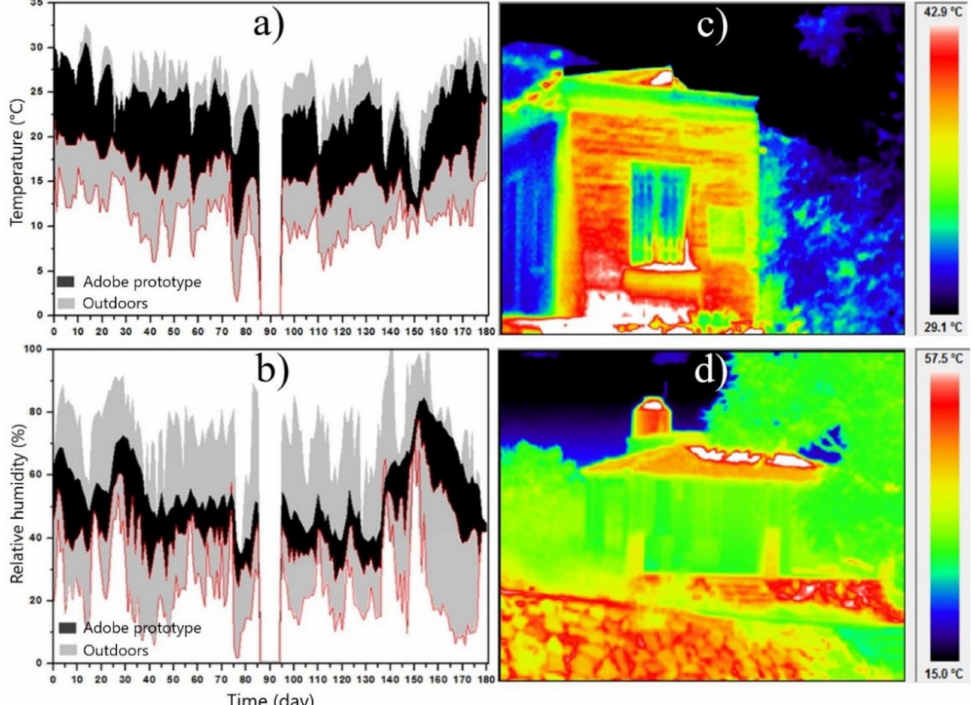
Figure 3. ( a ) Temperature and ( b ) relative humidity of the adobe prototype and outdoor environment. Thermographic images of the adobe prototype showing ( c ) the right side of the building, and ( d ) the facade of the